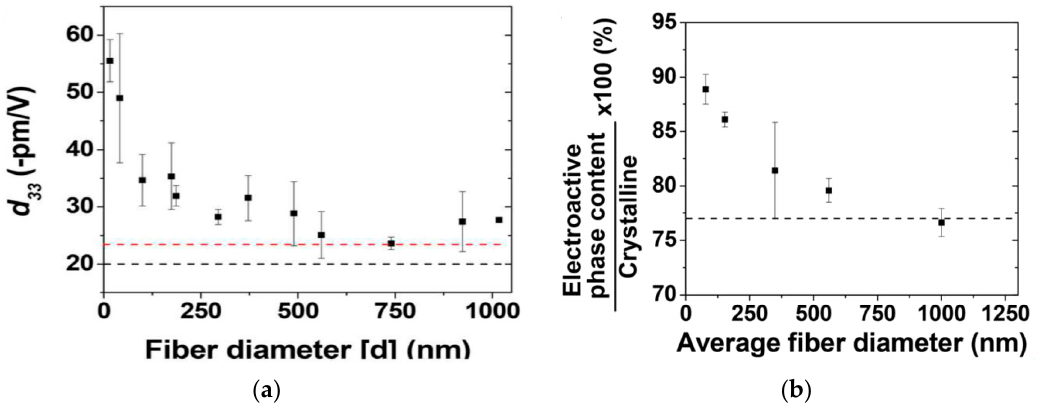
Figure 18. ( a ) Measured d 33 as a function of fiber diameter from PFM. The red dashed line corresponds to the measured d 33 of a 80 µm thick film, and the black dashed line is the d 33 of bulk P(VDF-TrFE). Thick P(VDF-TrFE) film (80 µm) was made by drop-casting and employed as a reference. ( b ) Electroactive phase content determined by FTIR as a function of mean fiber diameter. The black dashed line represents the measured electroactive active content of a thick film prepared by drop-casting. Reproduced with permission from [152], published by Royal Society of Chemistry, 2016.